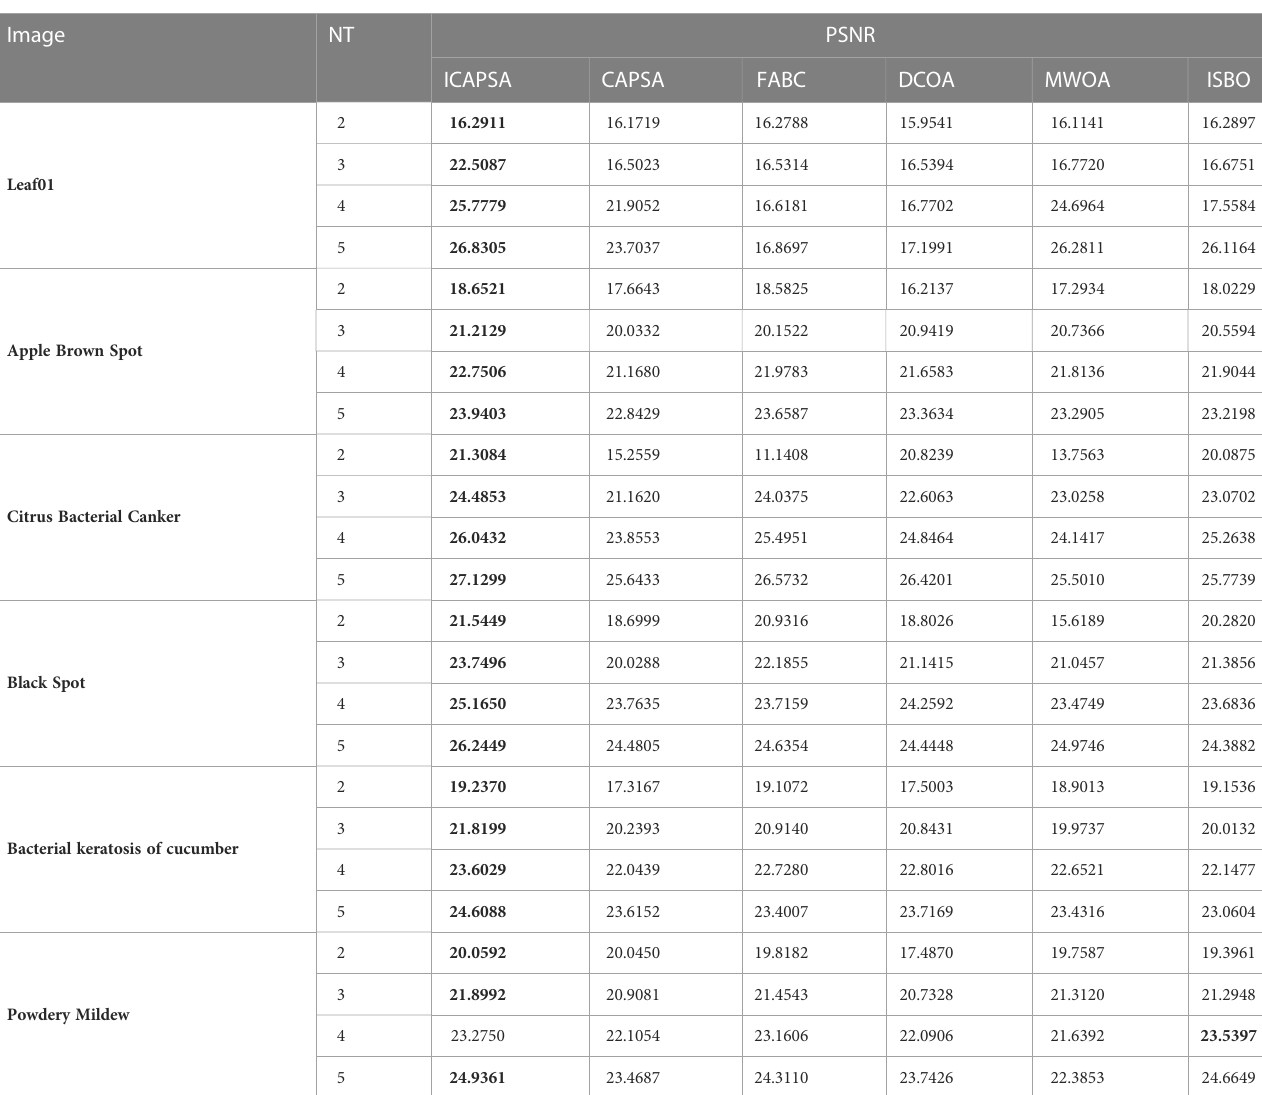
TABLE 5 Thresholding results with different segmentation